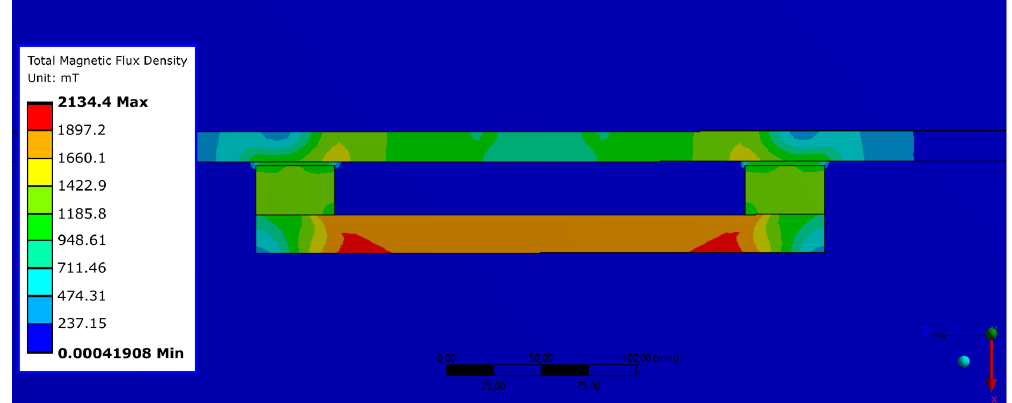
Figure 8. Field induction in magnetic core, guide rail, and air domain—cross-section.